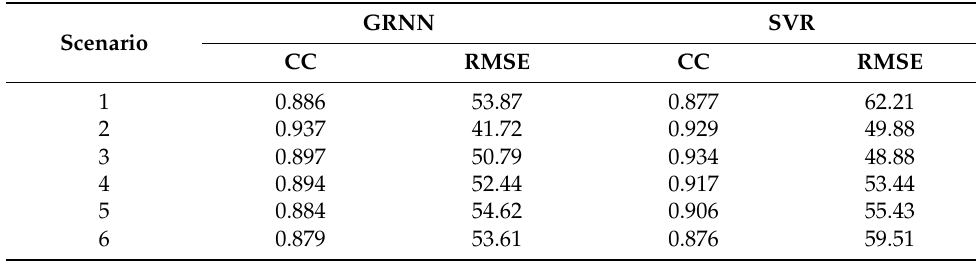
Table 4. Results of prediction by using GRNN and SVR model with various weather parameter scenarios, as described in Table